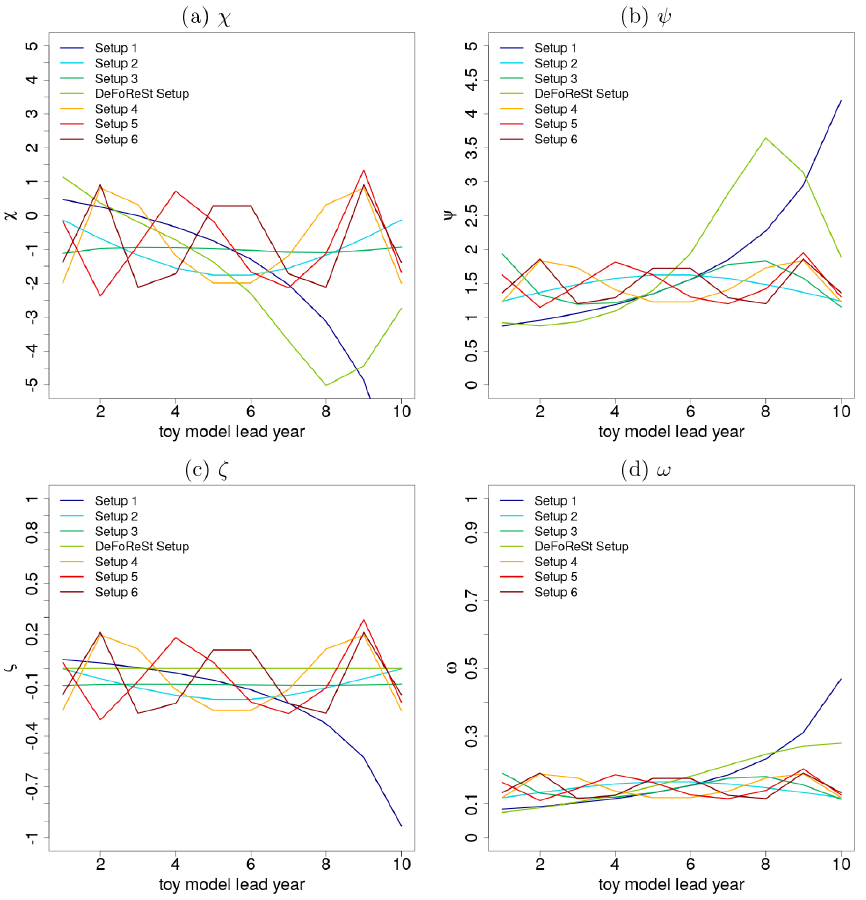
Figure 5. χ(t,τ) (a) and ψ(t,τ) (b) which are related to the unconditional and conditional bias, as well as ζ(t,τ) (c) and ω(t,τ) (d) which are related to the unconditional and conditional dispersion of the ensemble spread for the different toy model setups (colored lines) as a function of lead year τ with respect to start year t =